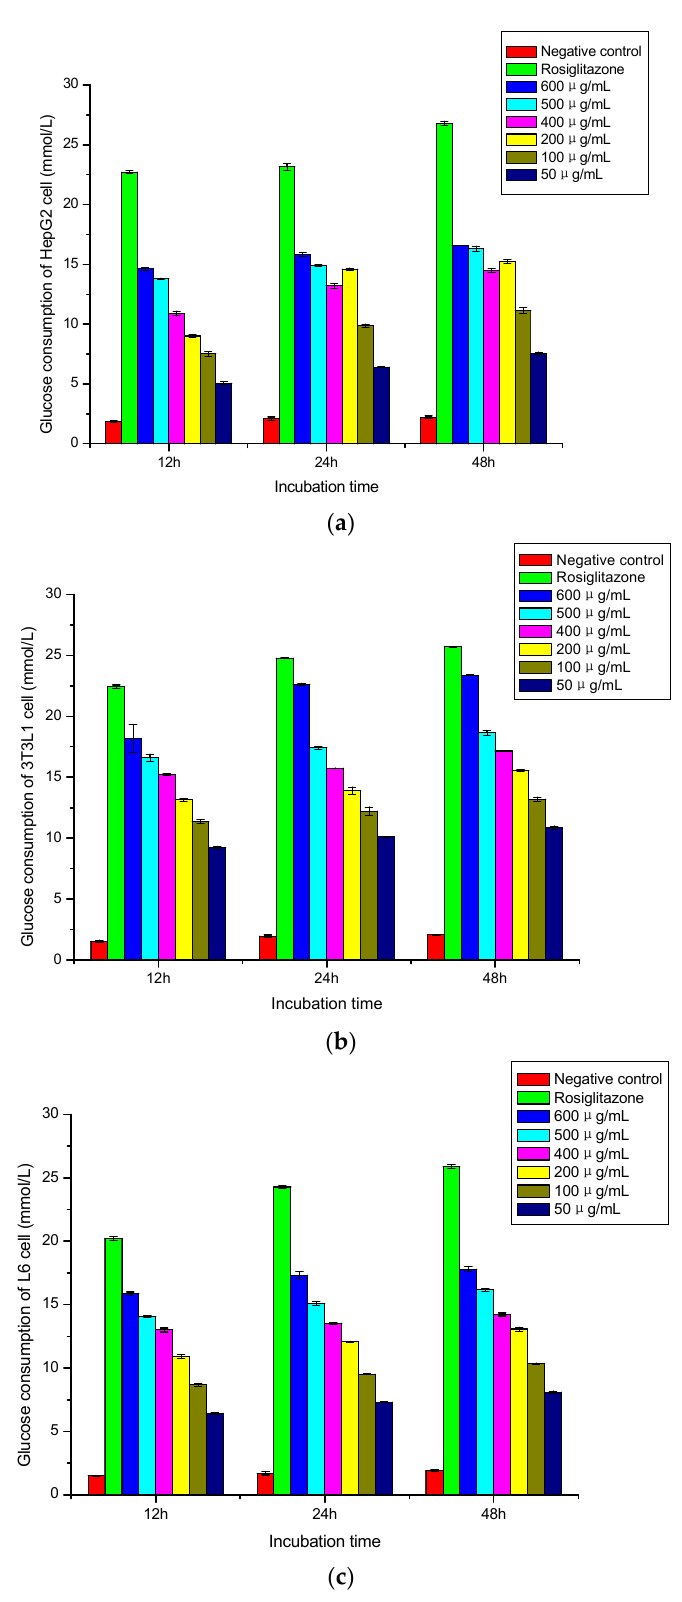
Figure 7. ( a ) Influence of H-1-2 on HepG2 cell glucose consumption at different incubation times (mean ± standard deviation, n = 5); ( b ) influence of H-1-2 on 3T3L1 cell glucose consumption at different incubation times (mean ± standard deviation, n = 5); and ( c ) influence of H-1-2 on L6 cell glucose consumption at different incubation times (mean ± standard deviation, n = 5).